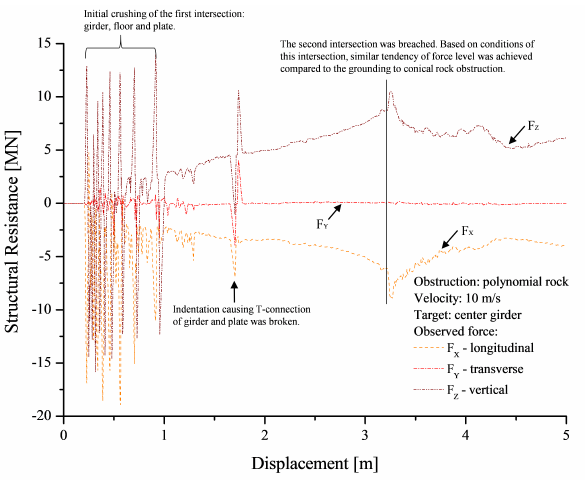
Figure 12: Structural resistance of the double bottom impacted by the selected obstruction: polynomial rock.